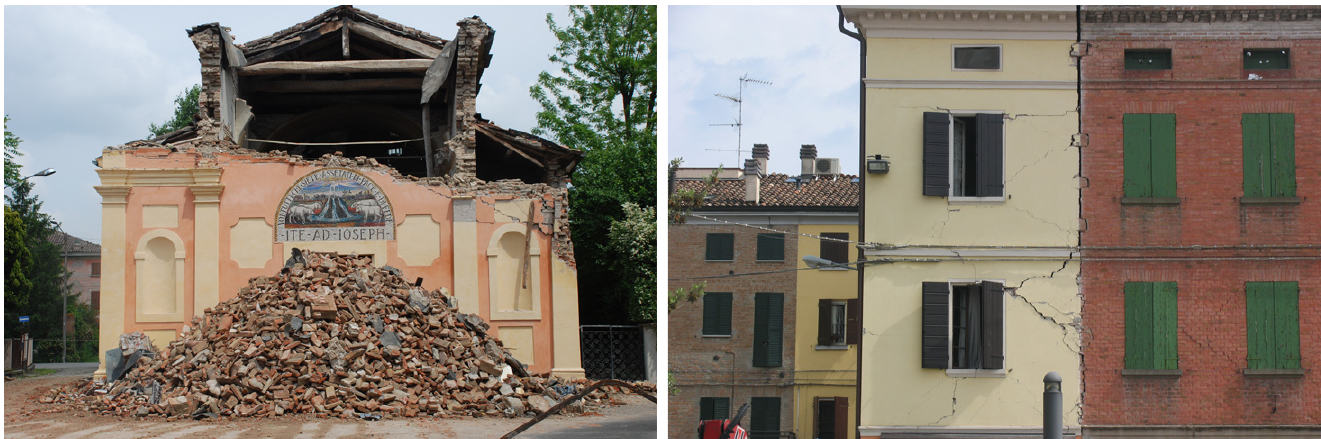
Figure 3. a. Partial collapse of a monumental building: the S. Giuseppe church in San Felice sul Panaro. b. Widespread cracks in a class B building in